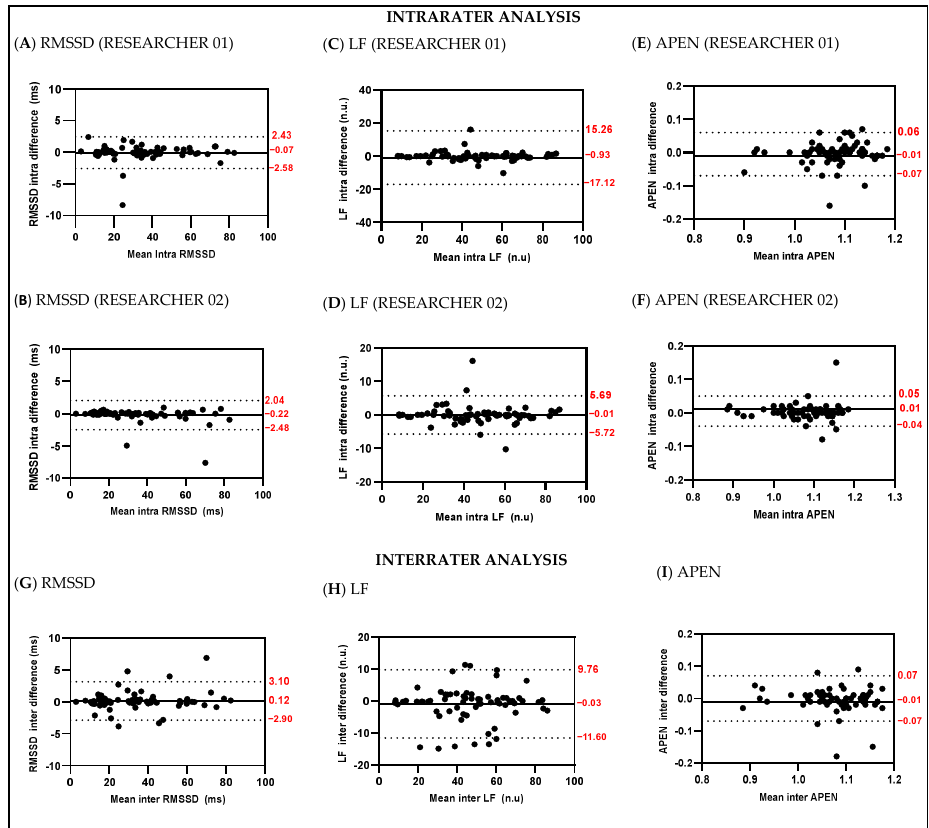
Figure 2. Bland-Altman plots for the RMSSD, LF and APEN intrarater and